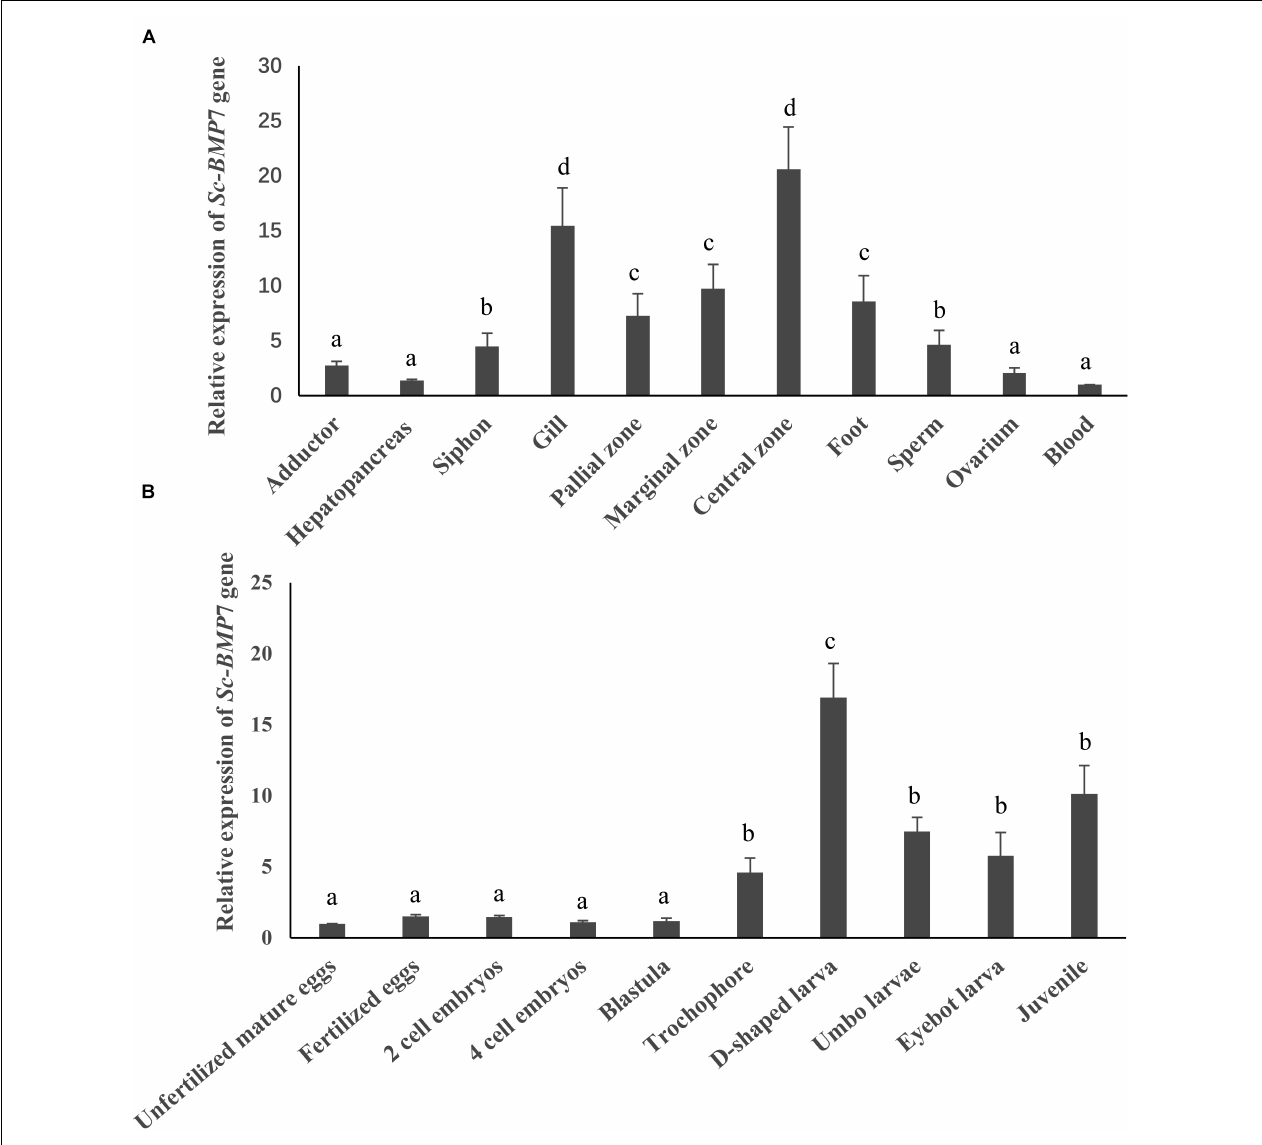
FIGURE 2 | Quantitative expression analysis of Sc-BMP 7, (A) Gene expression difference analysis of Sc-BMP 7 in different tissues. The same letters indicate no difference in the level of expression, whereas different letters indicate significant differences in expression levels among various tissues ( P < 0.05, based on ANOVA, n = 4). (B) Gene expression difference analysis of Sc-BMP 7 in different developmental stages. The same letters indicate no difference in the level of expression, whereas different letters indicate significant differences in expression levels among various developmental stages ( P < 0.05, based on ANOVA, n >